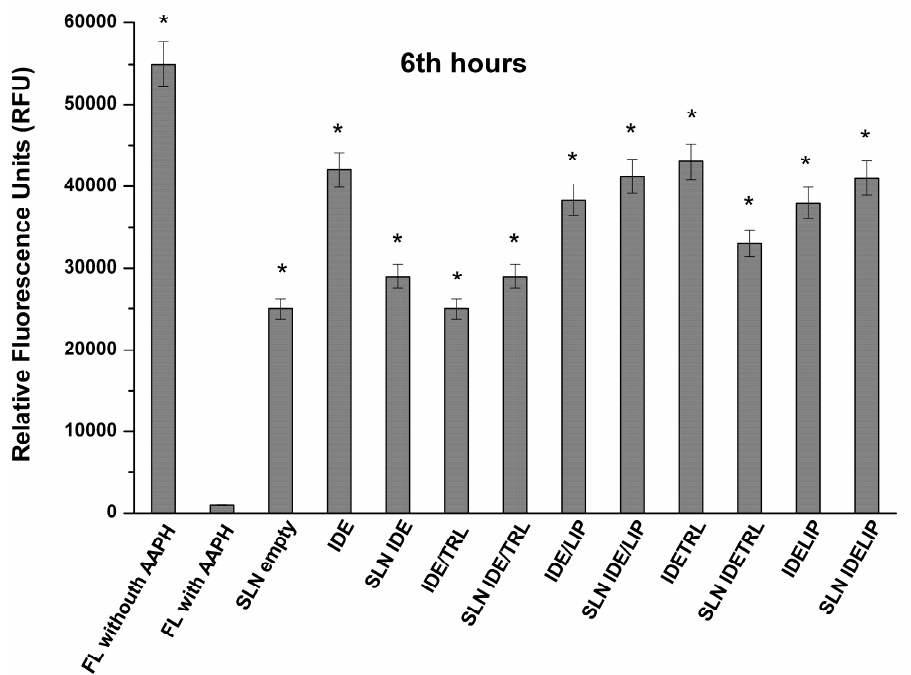
Figure 4. Antioxidant efficiency of IDE, IDETRL, IDELIP, and of the physical mixtures IDE/TRL and IDE/LIP, free or loaded into SLN, at the 6th hour. Data represent the mean of three independent experiments ± SD. * p < 0.05 with respect to the positive control.